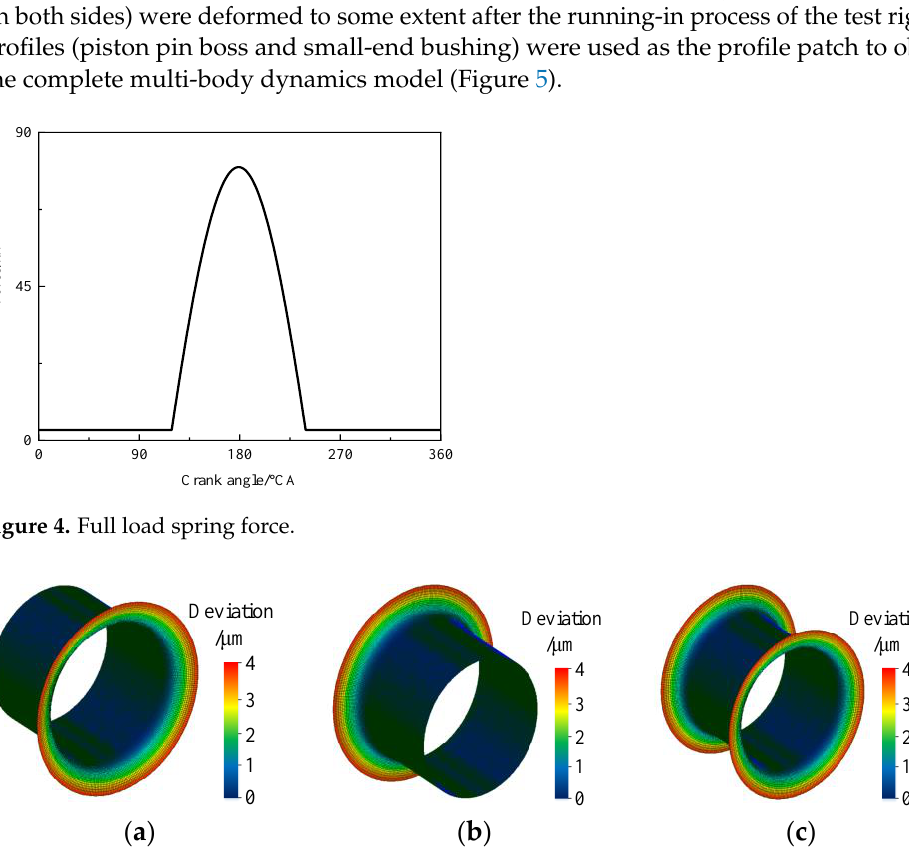
Figure 3. Dynamic model of the test rig.